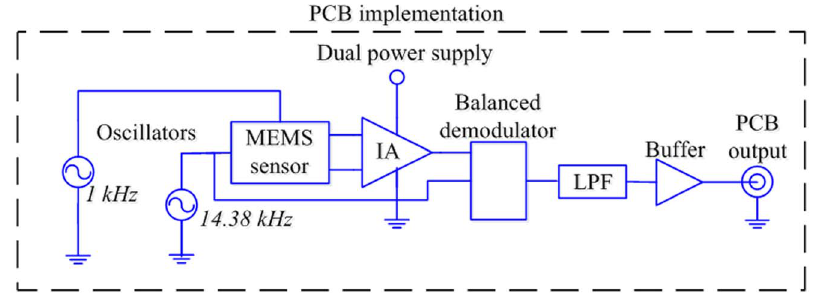
Figure 3. Block diagram of the signal conditioning system of the MEMS magnetic field sensor.